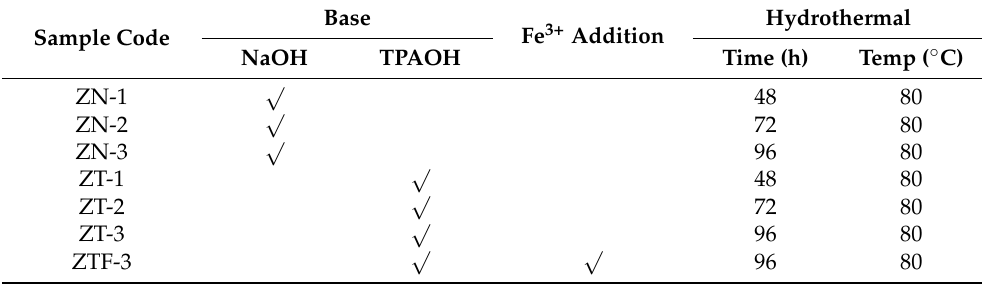
Table 4. Sample annotation and variation of synthesis’s